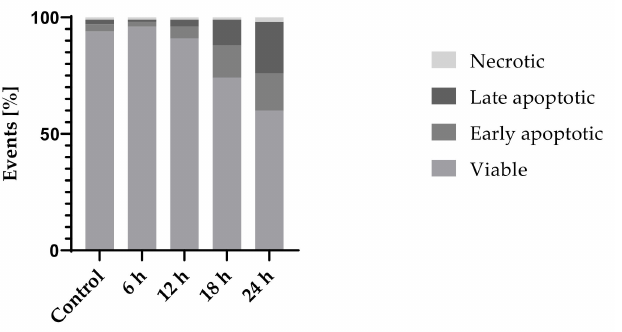
Figure 11. Alexa Fluor 488-annexin V and PI staining of the AGS cell line after exposure to 3 at 250 µ M concentration.